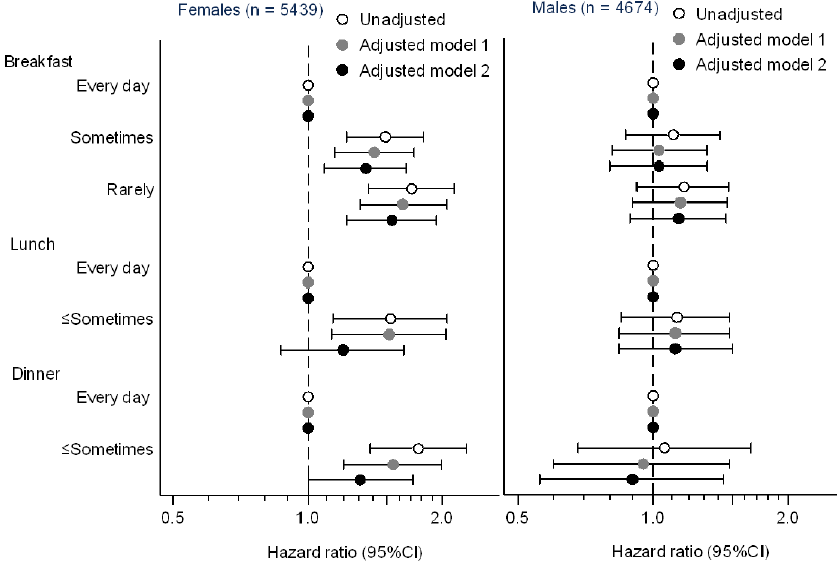
Figure 3. Associations of the frequency of breakfast, lunch, and dinner with the incidence of proteinuria. CI, confidence interval. Model 1 adjusted for age (year), smoking status (non-, past, and current smokers), drinking frequency (rarely, 1–3, 4–6, and 7 days/week), body mass index (kg/m 2 ), snacking (rarely, 1 or 2, 3–5, and ≥ 6 days/week), systolic blood pressure (mg/dL), total cholesterol (mg/dL), triglyceride (mg/dL), HbA1c (%), estimated glomerular filtration rate (mL/min/1.73 m 2 ), urinary protein (- and ±), and current treatments for hypertension, dyslipidemia, diabetes mellitus, and cardiovascular disease (yes vs. no). Model 2 adjusted for covariates in model 1 and the frequencies of breakfast, lunch, and dinner.